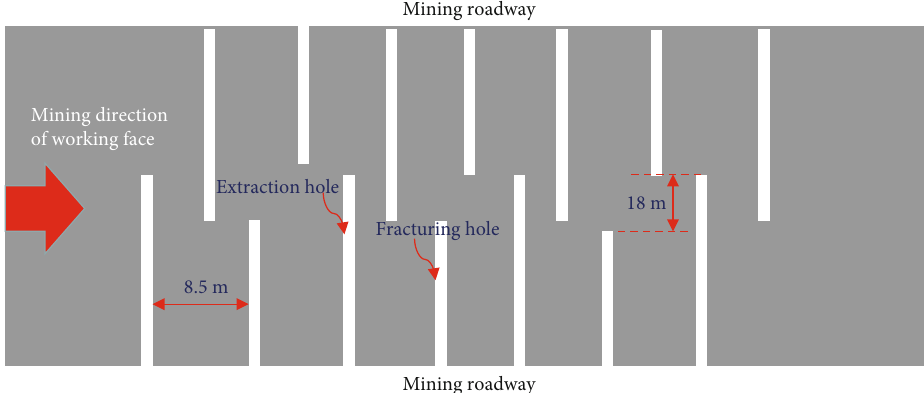
Figure 9: Layout of pumping and pressure relief boreholes in working